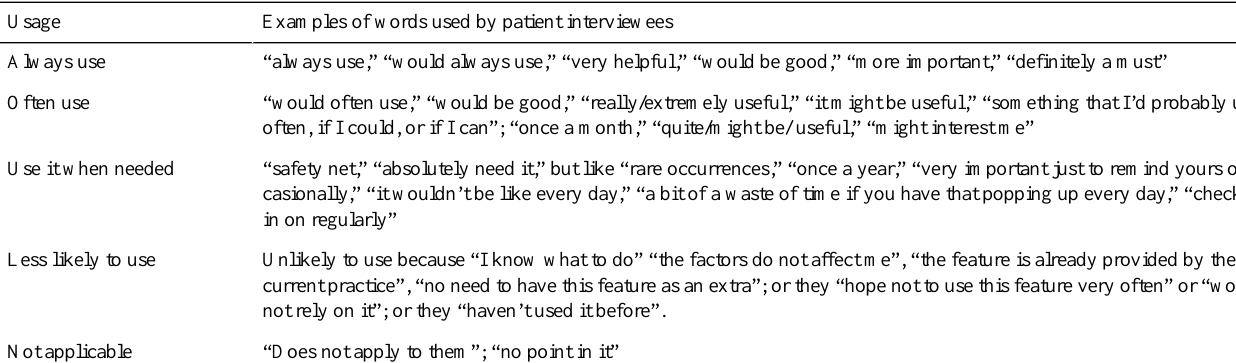
Table 1. Defining patients’perceptions of potential future usage. Examples of words used by patient